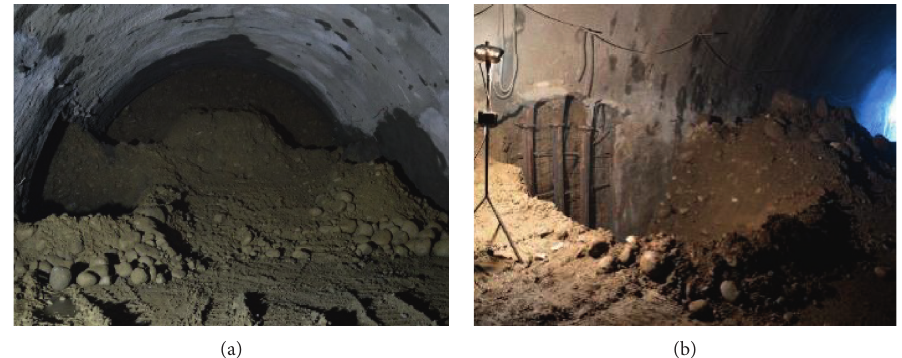
Figure 10: Section distribution of complementary cyclic excavation method. (a) Distribution of excavation surface of upper and middle steps. (b) Construction on one side of lower steps.